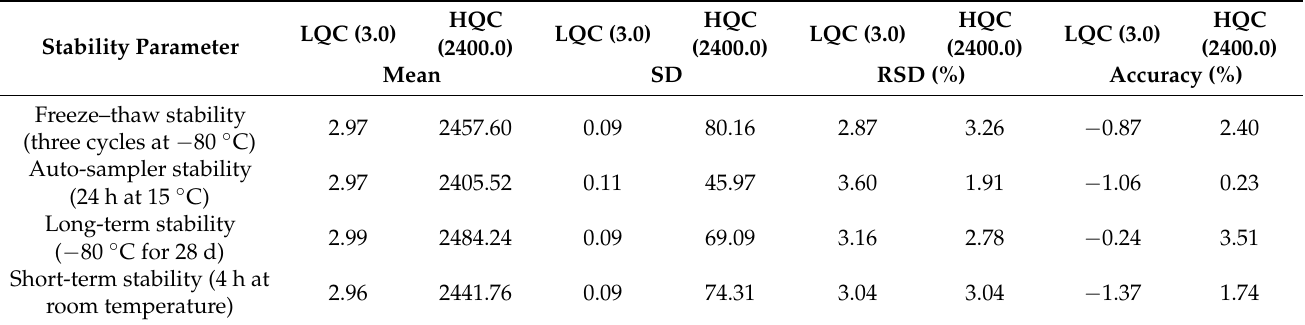
Table 6. Summary of the stability analysis of